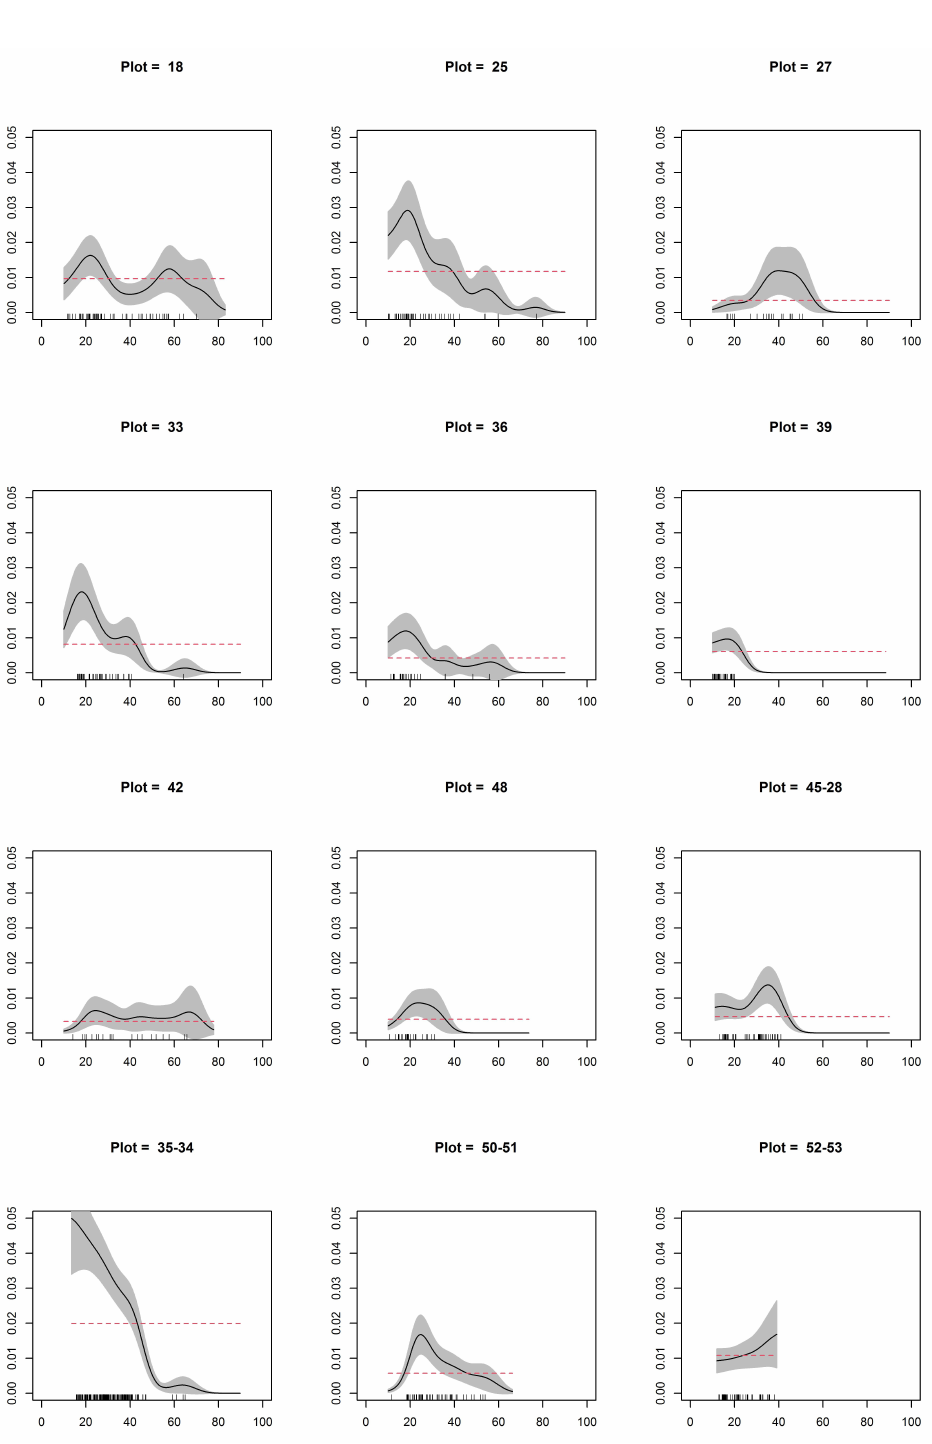
Figure A3. Estimated intensity of regeneration as a function of the ground cover. The solid black line represents the estimated function ( ρ (z)), the red dotted line represents the mean, and pointwise 95% confidence intervals for the true value are plotted as grey shading.